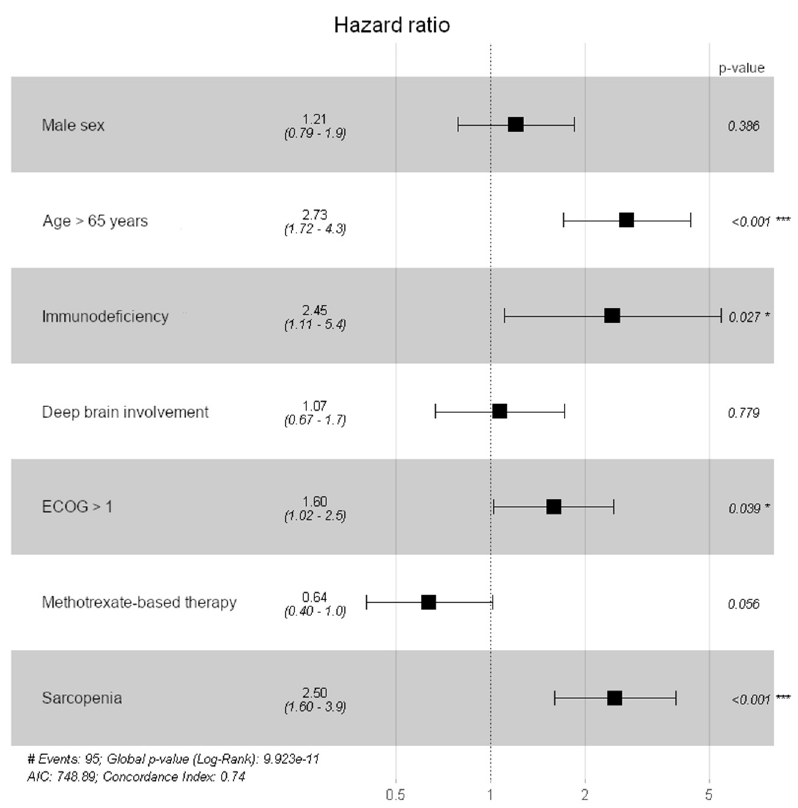
Figure 3. Forest plot to visualize the impact on all possible explanatory variables on overall sur- vival (* p < 0.05; *** p <